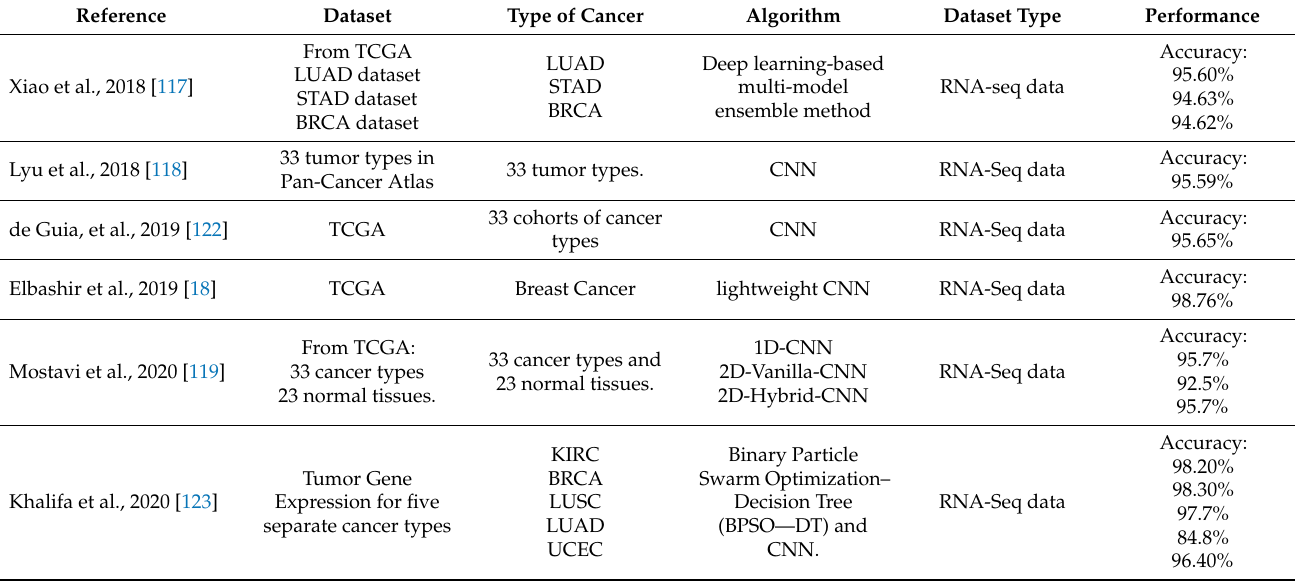
Table 9. Deep learning-based CNN methods for gene expression